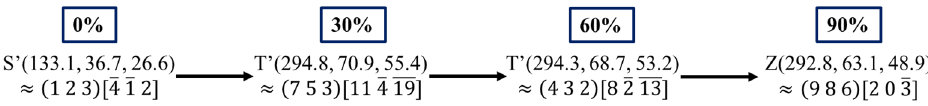
Figure 12. Orientation evolution of Z orientation simulated with MCTS-model.